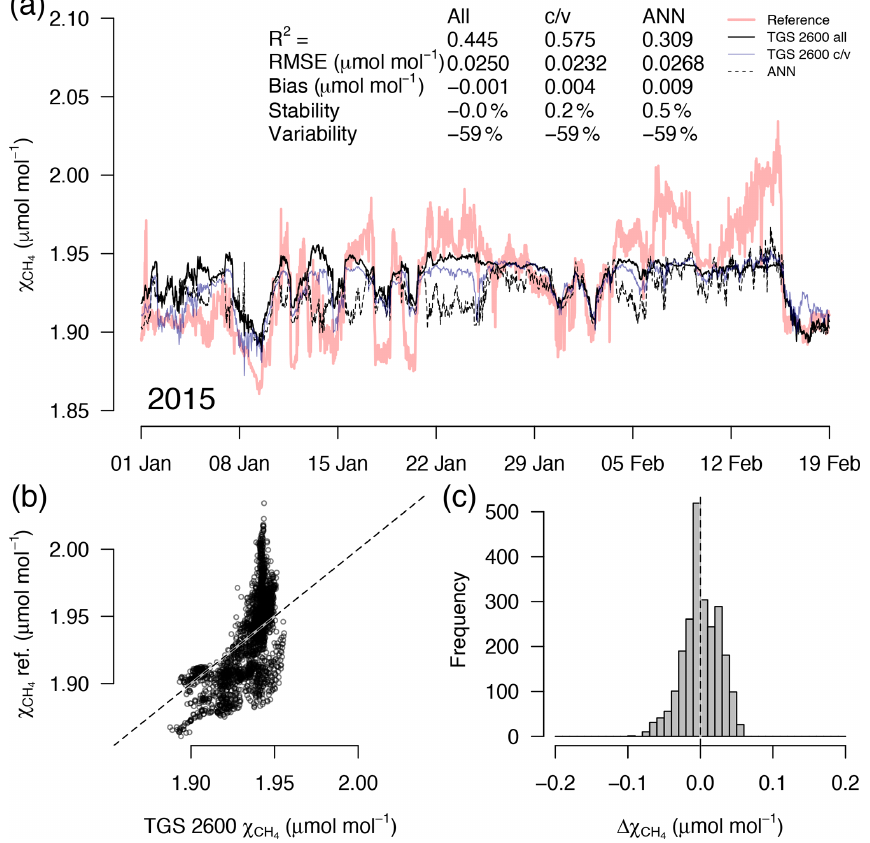
Figure 7. As in Fig. 5 but with measurements from a 7-week period in midwinter with temperatures plunging down to − 40 ◦ C. High CH 4 mole fractions coincide with the coldest temperatures (see Fig. 4). This example belongs to the validation period of the TGS 2600 c/v and ANN